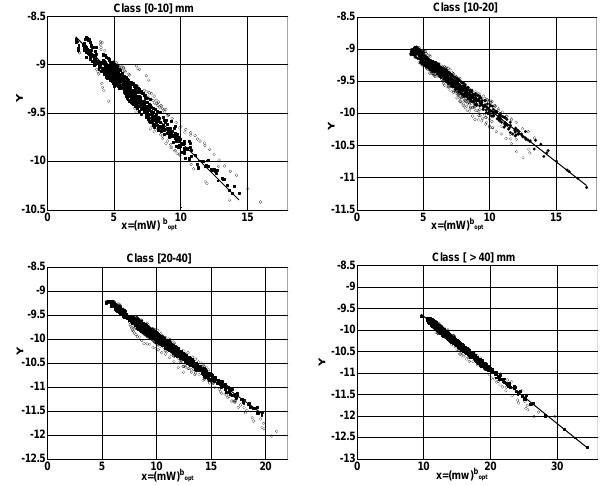
Fig. 5. Type-2 modified Langley for each of the four water vapour classes. Open circles are points discarded from the quality check selection. W is from GPS2; b is the retrieved optimal value for each class, see Table